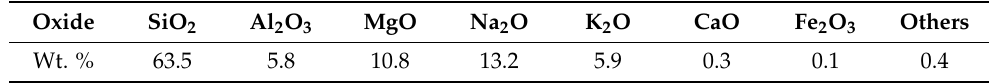
Table 1. Mean chemical composition of the glass used.